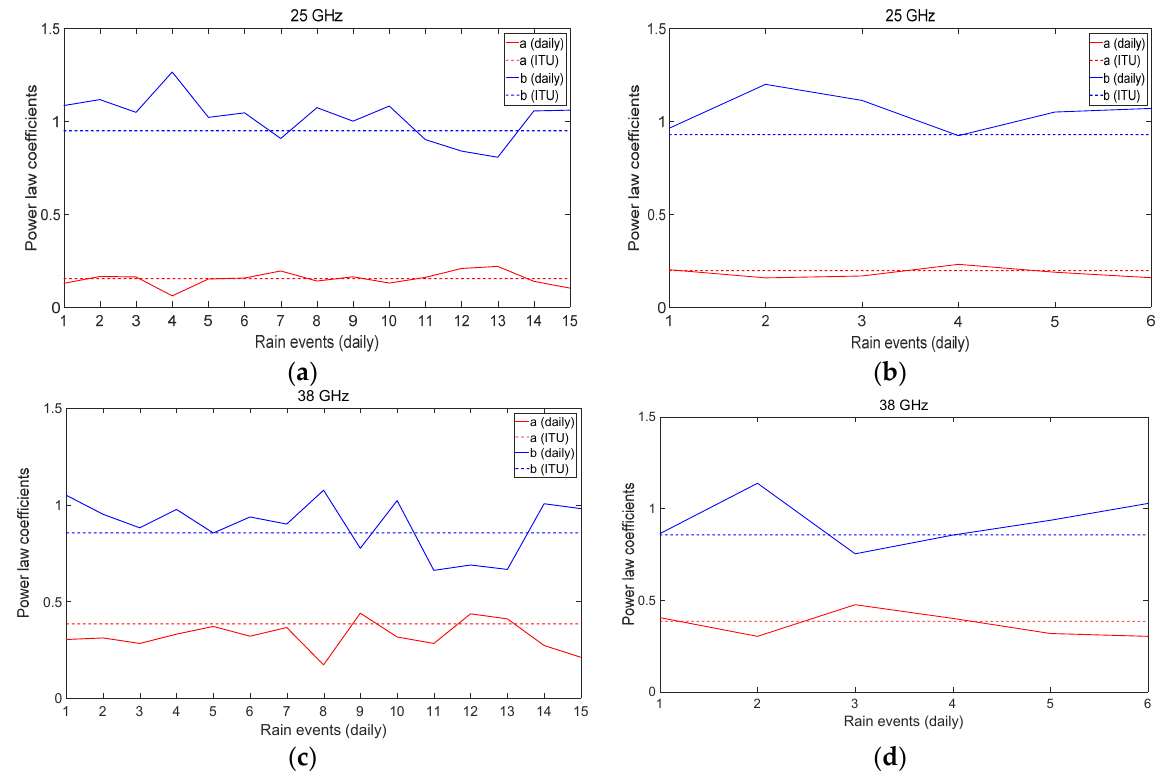
Figure 5. The comparison between power law coefficients ( a, b ) from the ITU-R P. 838-3 and the values derived from the measurement for ( a ) a 25 GHz link in stratiform precipitation ( b ) a 25 GHz link in convective precipitation ( c ) a 38 GHz link in stratiform precipitation ( d ) a 38 GHz link in convective